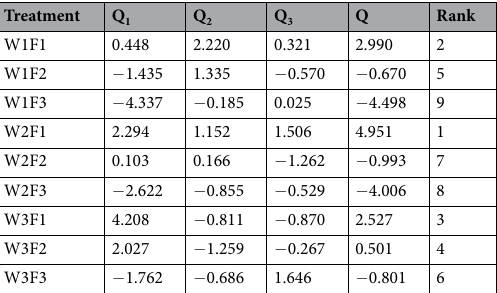
Table 2. The score and rank of the comprehensive fruit yield and quality, WUE, and PFP values calculated in a PCA of all the treatments. The treatments are noted as W1, 100% ET 0 ; W2, 75% ET 0 ; W3, 50% ET 0 ;